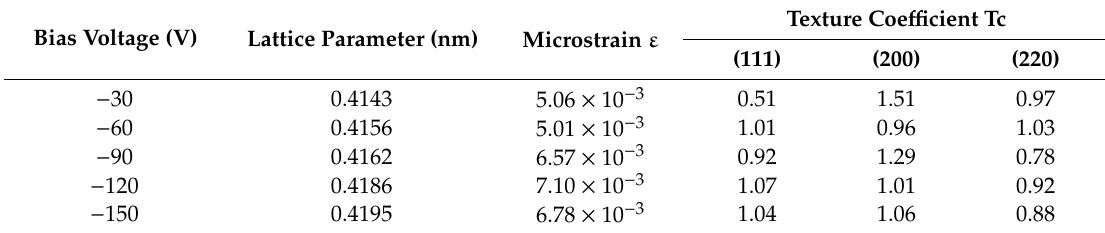
Table 5. Structural parameter values and texture coe ffi cients in CrAlN layers created under various bias